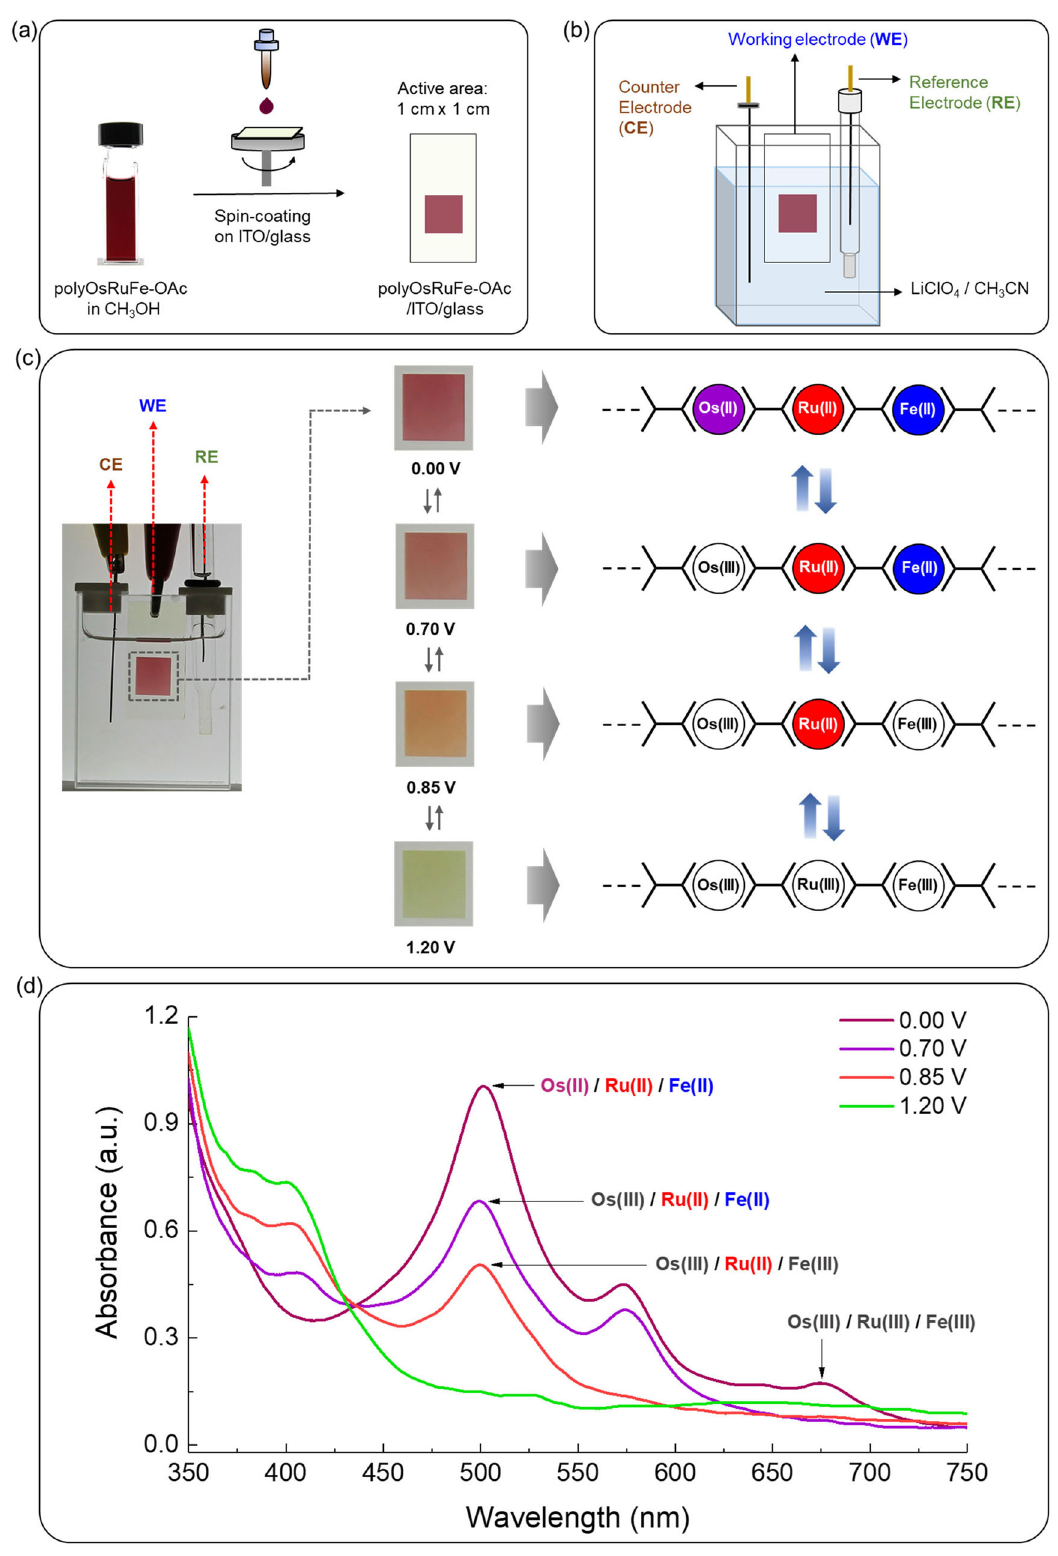
Fig. 8 Preparation of a thin fi lm of polyOsRuFe-OAc on ITO/glass and in situ spectroelectrochemical measurements. a Schematic view of the preparation of spin-coating thin fi lm on ITO/glass using CH 3 OH solution of polyOsRuFe-OAc. b Schematic representation of the three-electrode electrochemical measurement setup; polyOsRuFe-OAc/ITO/glass as WE, a platinum wire as the CE, and Ag/Ag + as the reference electrode (RE). c Actual view of the three-electrode electrochemical cell with a side panel showing photographs of the fi lm (1 cm× 1 cm) at different applied potentials. Side bar: the mechanistic view of the polymer for the color change is shown schematically. d In situ UV – vis spectra of a polyOsRuFe-OAc fi lm on ITO/glass at different applied potentials of 0.70, 0.85, and 1.20 V for stepwise oxidation of Os(II), Fe(II), and Ru(II),